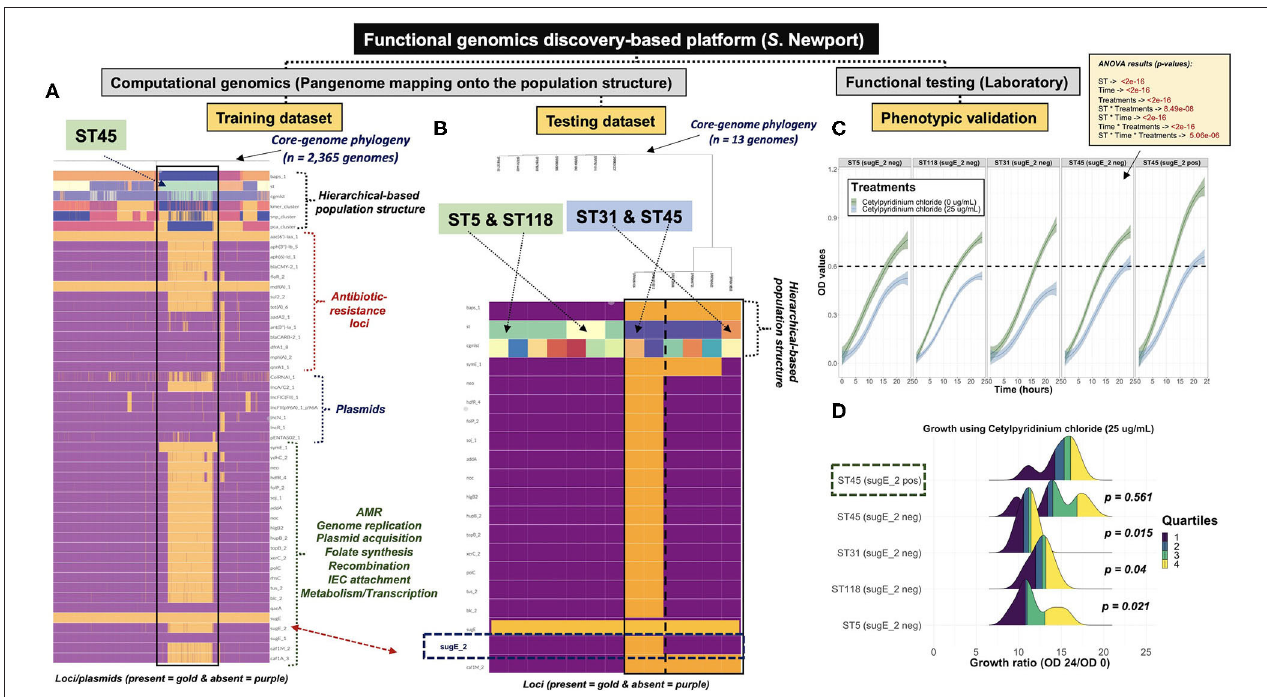
FIGURE 6 | Functional genomics discovery-based platform revealed a quantitative trait preferentially associated in the S . Newport ST45 lineage. (A) Core-genome phylogeny-based analysis combining the S . Newport hierarchical population structure, along with loci (e.g., AMR and metabolic genes) and plasmids, differentiated ST45 from other STs. A training dataset containing 2,365 genomes was used for discovery of genomic attributes preferentially inherited by ST45. (B) A testing dataset containing representative STs and distinct cgMLSTs, selected from human clinical isolates ( n = 13) was used for in silico and in vitro validation of predicted phenotypes. Specifically, sugE-2 negative ST5 ( n = 2), ST118 ( n = 5), ST31 ( n = 1), and ST45 ( n = 3) were predicted to be more susceptible to cetylpyridinium chloride-CPC (i.e., cationic quaternary ammonium compound—quats) than ST45 sugE-2 positive ( n = 2) isolates. All isolates contained sugE-1 , named as sugE in plot B. Phenotypic testing was done over time (for 24h with growth measured every 2h) under aerobic condition (i.e., quats exposure occurs in the environment), while controlling for the initial population size (10 5 CFU/ml) across all STs. (C) CPC treatment of 25 µ g/ml was used to test for quats resistance. (C) On average both ST45, containing or not the sugE-2 locus, demonstrated higher resistance for CPC over time. Of note, although we had genome sequences for all 13 isolates (B) , we lacked an isolate for one of the five ST118 isolates for phenotypic testing ( n = 12 isolates). (D) Comparative analysis of growth ratio between OD 600 values from 24h to time 0 (OD 600 24/OD 600 0), under CPC treatment (25 µ g/ml), revealed no significant difference on the average growth between ST45 representatives, but ST45 was more resistant than all other STs. Of note, ST45 sugE-2 positive has a bimodal, rather than trimodal (ST45 sugE-2 negative) distribution, that is right skewed, suggesting an important shift in the resistance phenotype underlying this quantitative trait. For plots (A) and (B) , each column represents a unique genome, and each row represents either a locus or plasmid. For either loci or plasmids, presence is depicted by gold, and absence by purple. For plots (C) and (D) , p -values were calculated using a multivariate ANOVA model or pairwise t -test (i.e., comparing to the reference group ST45 sugE-2 positive), respectively. Core-genome phylogeny guided mapping of population structure and genetic elements were visualized with phandango (A,B)